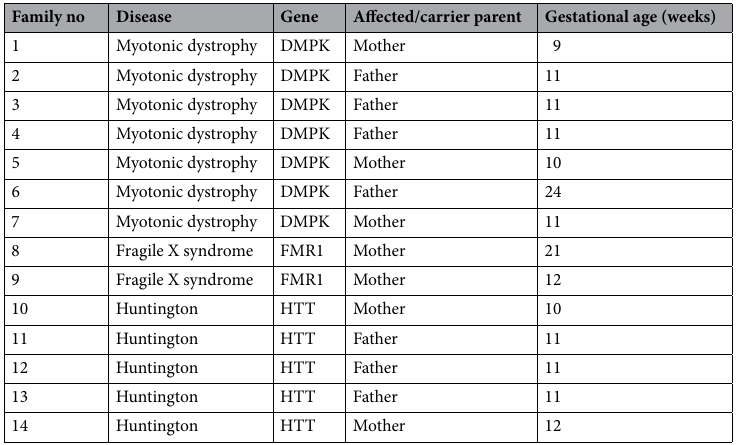
Table 1. Data of studied families.